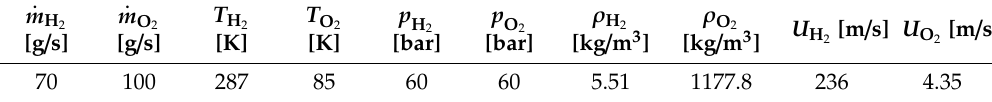
Table 2. Propellant supply conditions for RCM-3 C60